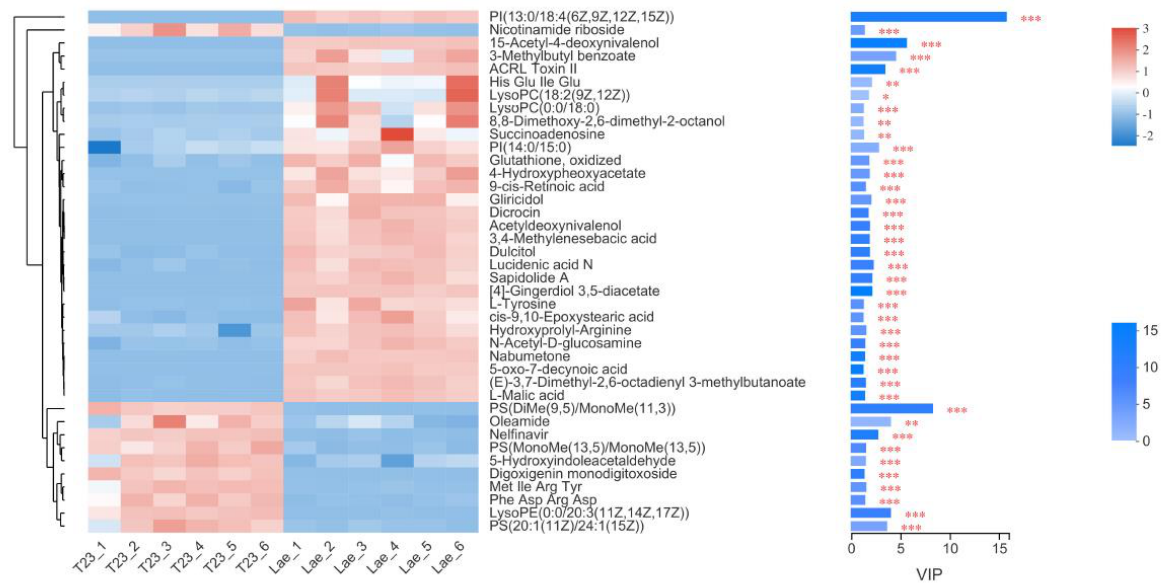
Figure 6. Variable importance in projection (VIP) scores of significantly different metabolites between T23 and Mlae1 strains. **: p < 0.01.